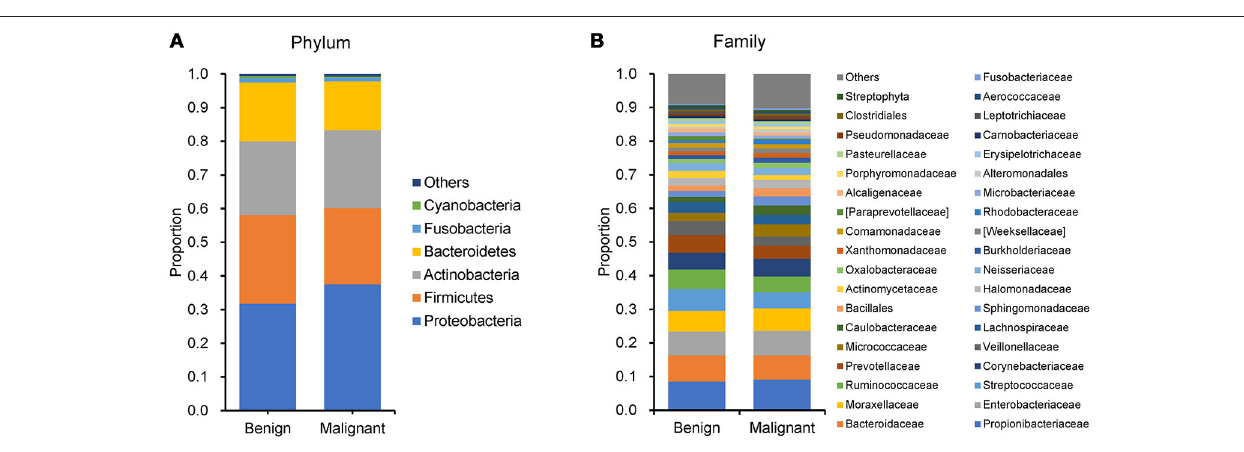
FIGURE 2 | Barplots of the taxonomic profiles of the benign and malignant breast tumor tissue microbiota. ( A) Phylum level; (B) Family